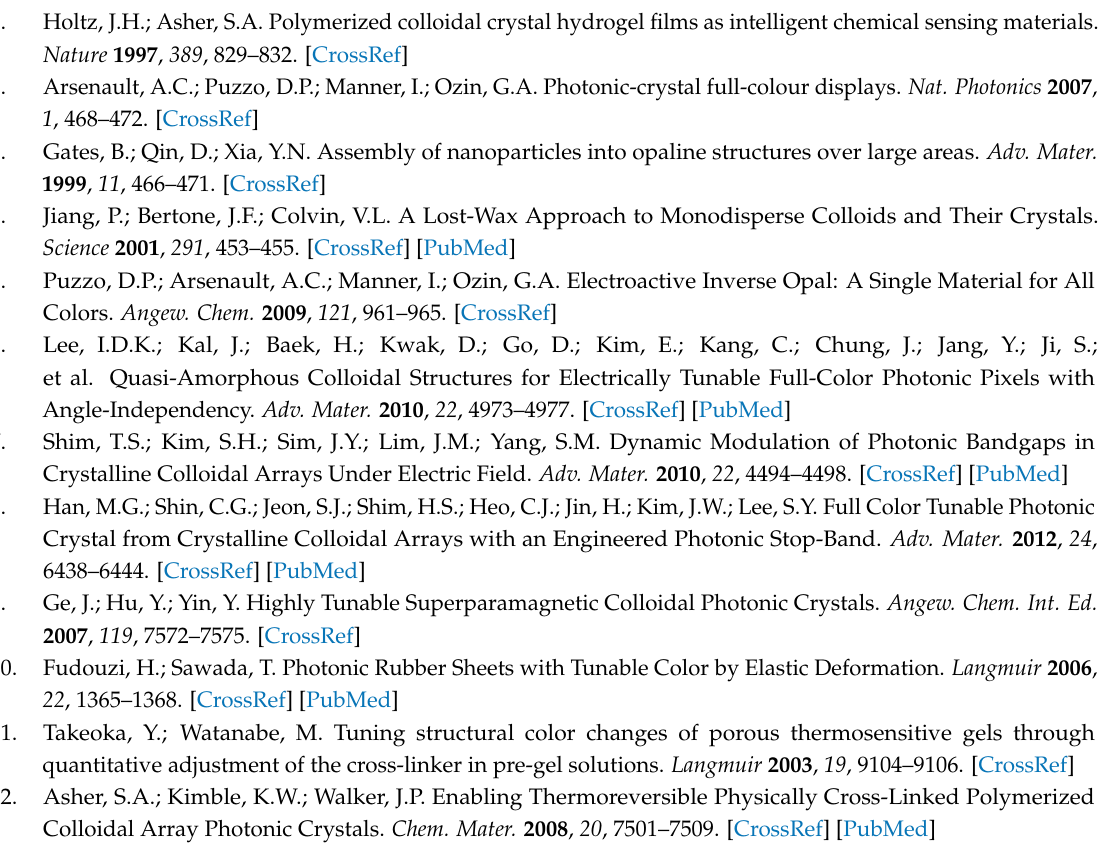
Figure S1: Plot of water fraction vs. humidity. Water fraction was calculated by the following equation; Figure S2: (a) Two of PHEMA (with crosslinker 2.5%) IOPGs on a single substrate having the same chemical compositions soaked in [BMIM][BF4] (b) Cross-section SEM Images of the IOPG; Figure S3: (a) Reflectance spectra of PHEMA (with crosslinker 2.5%) IOPG in ionic liquid of 1-Butyl-3-methylimidazolium hexafluorophosphate ([BMIM][PF6]) showing no wavelength shift at different humidity (b) Molecular structure of [BMIM][PF 6 ] ionic